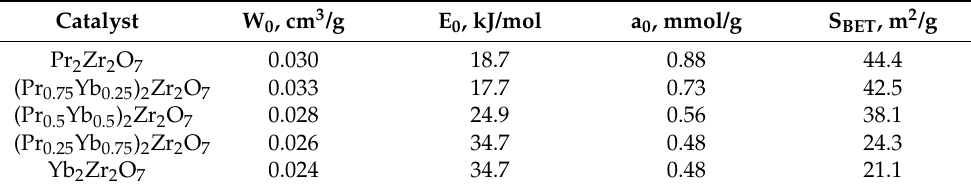
Table 1. Textural properties of Ln 2 Zr 2 O 7 catalysts.